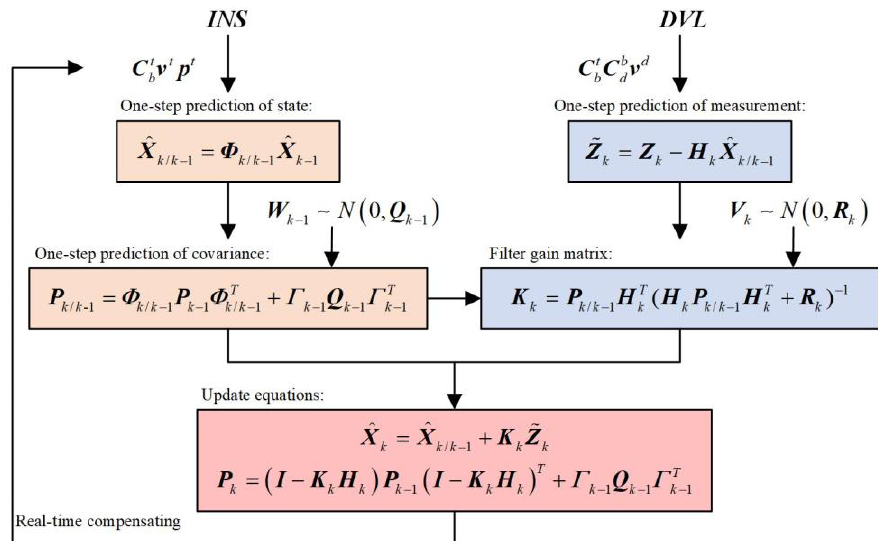
Figure 2. The standard Kalman filter flow diagram.